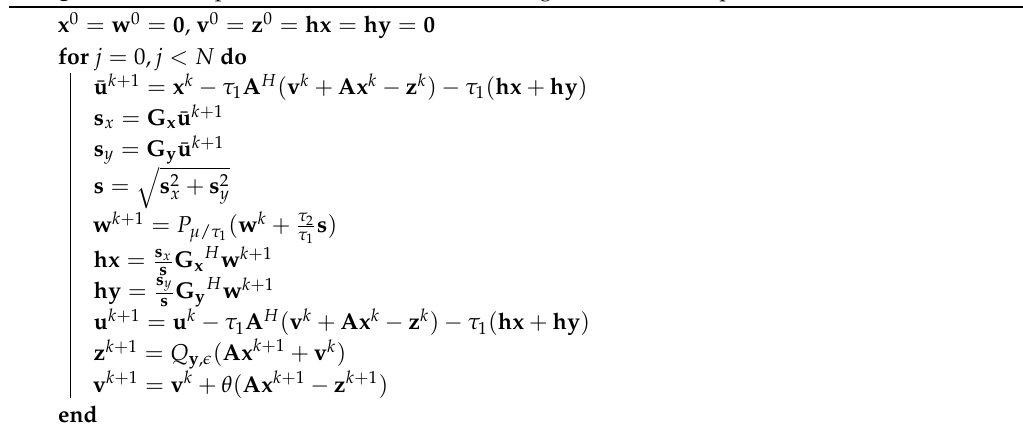
Algorithm 5: The pseudocode for the GBPDNA algorithm for isotropic total